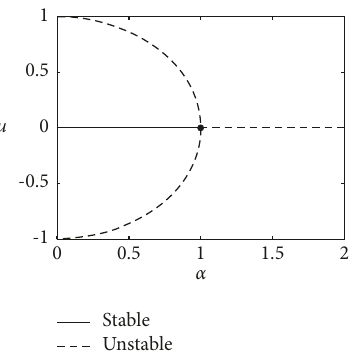
Figure 2: Static bifurcation of system (2) with α